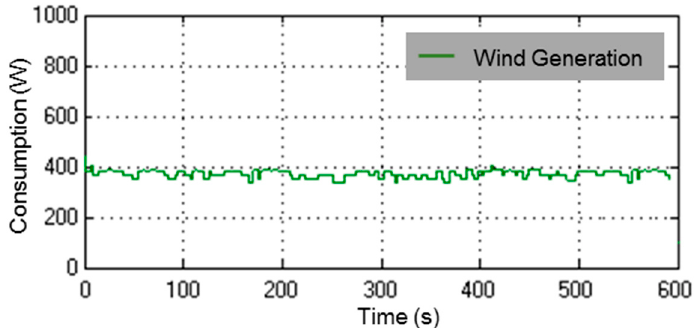
Figure 9. Real-time simulation of wind production curve.